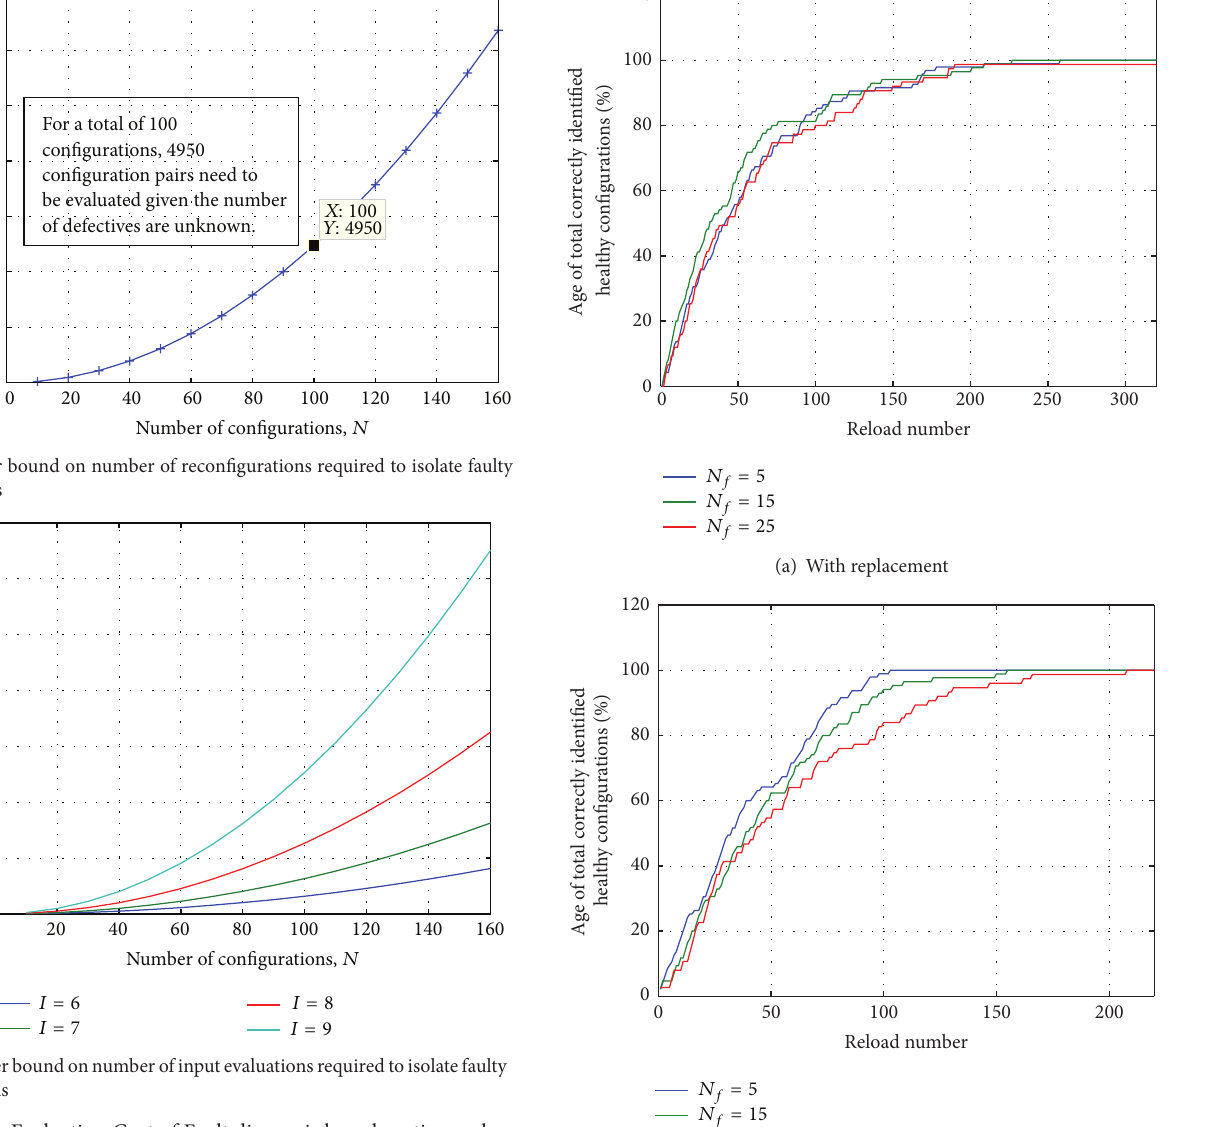
Figure 4: Evaluation Cost of Fault diagnosis by exhaustive evalua- tion of configuration pairs.